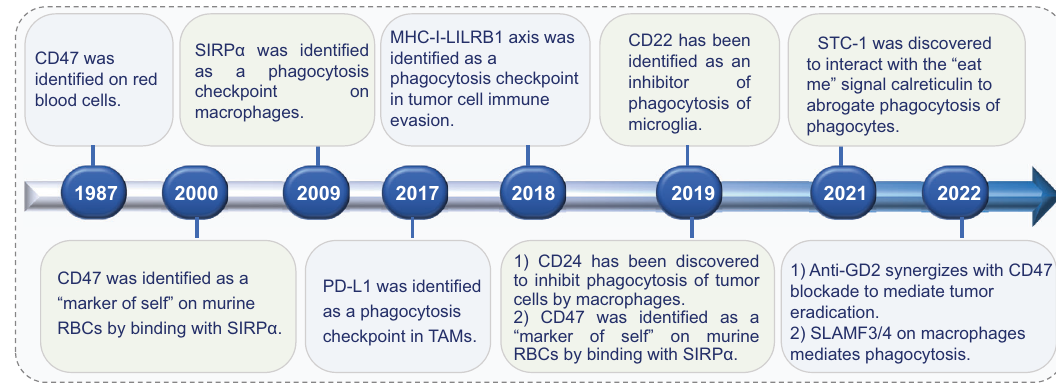
Fig. 1 Discovery of phagocytosis checkpoints